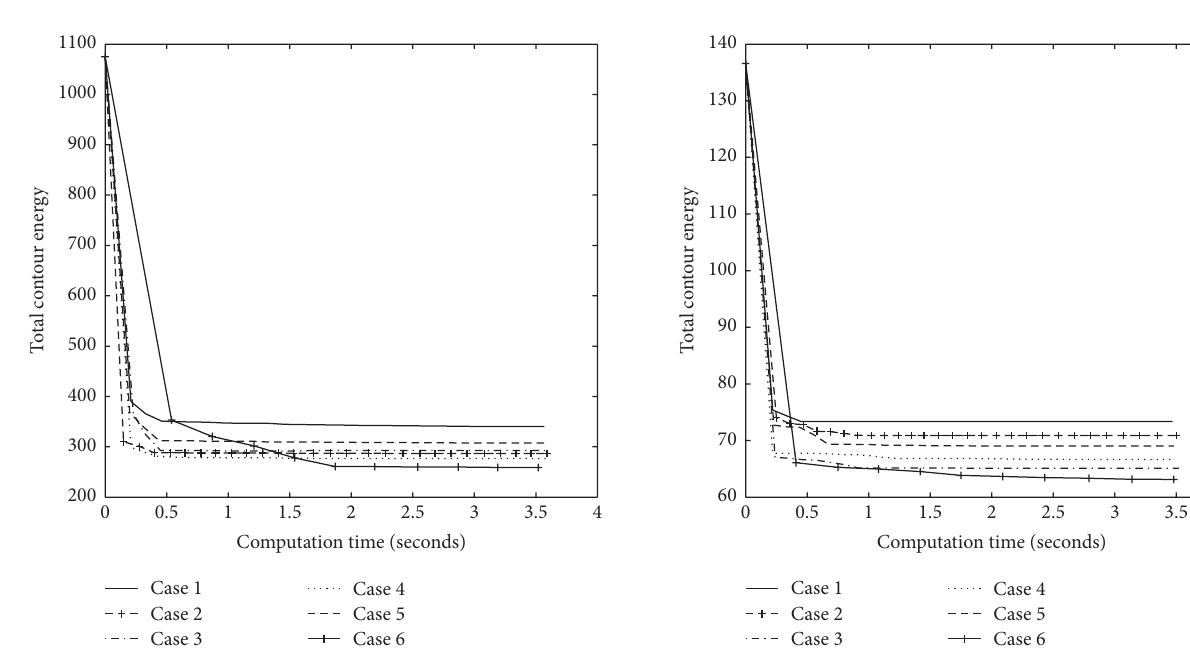
Figure 6: Contour energy versus computation time plot for “mul- tipopulation PSO” method with six different cases of inertia in case of “Vase” image.